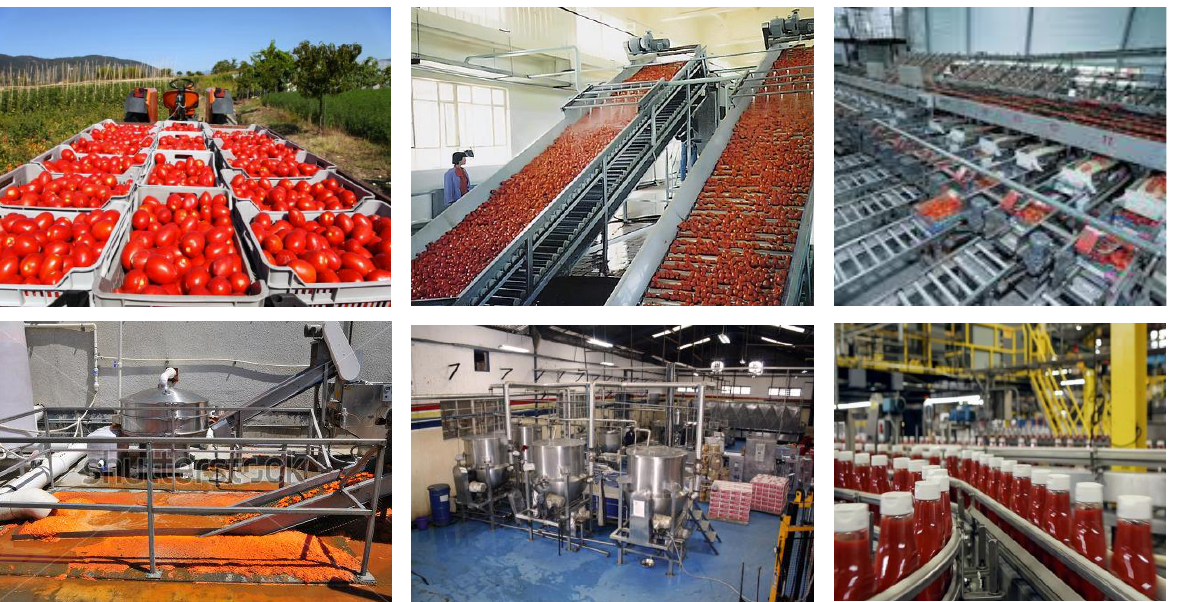
Figure 1. Conveyor system used in tomato processing